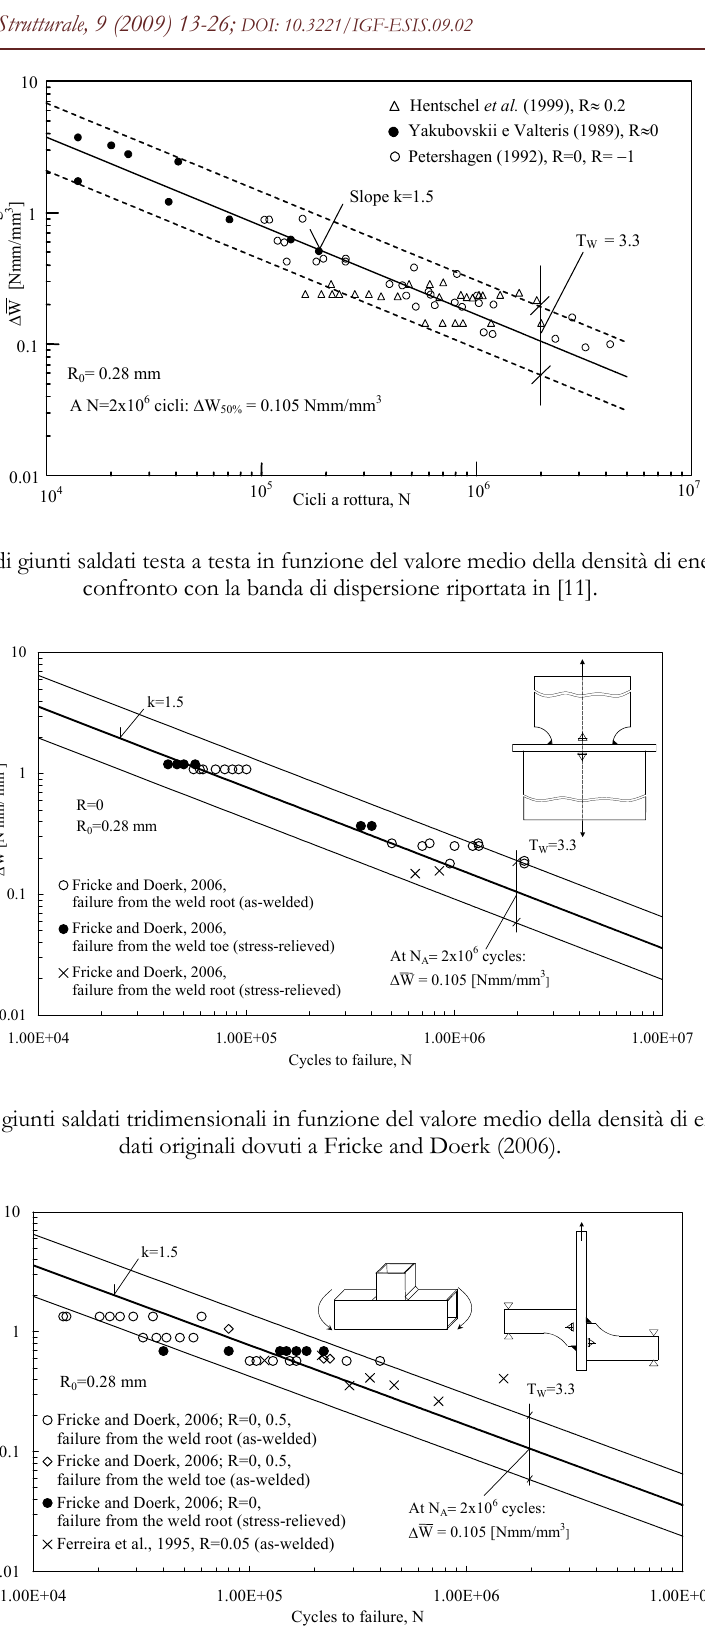
Figura 6: Resistenza a fatica di giunti saldati tridimensionali in funzione del valore medio della densità di energia di deformazione [22]; dati originali dovuti a (Fricke and Doerk, 2006) e a Ferreira et al.